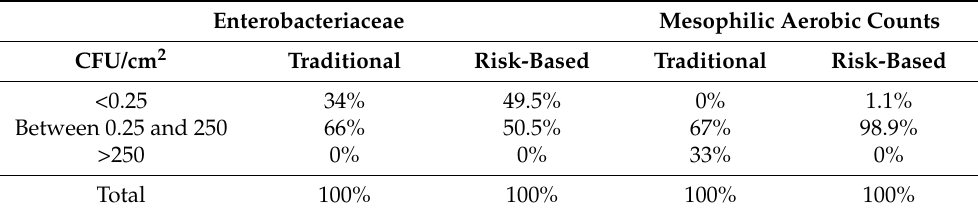
Table 4. Distribution of the results of the Enterobacteriaceae and mesophilic aerobic counts in CFU/cm 2 .